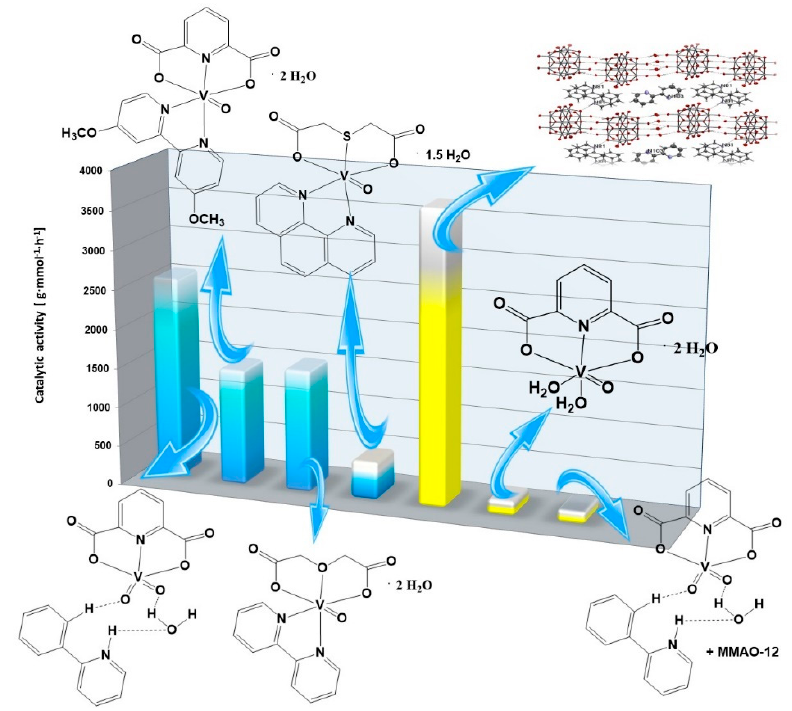
Figure 3. The catalytic activities of vanadium(IV,V) complexes for 2-propen-1-ol oligomerization (based on this work and [28,35,43,44]).